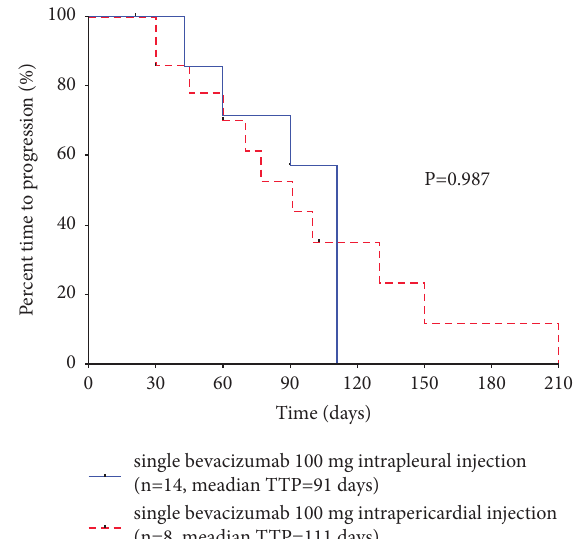
Figure 1: Time to progression of patients with single bevacizumab (100 mg) intrapleural or intrapericardial